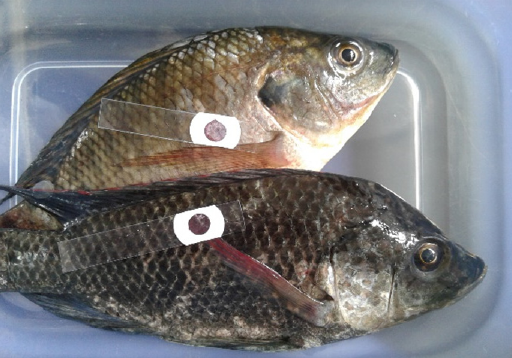
Figure 1. The fabricated sensors were attached onto the skin of the fish to detect the pH changes before the absorbance was measured with a UV-Vis spectrophotometer.